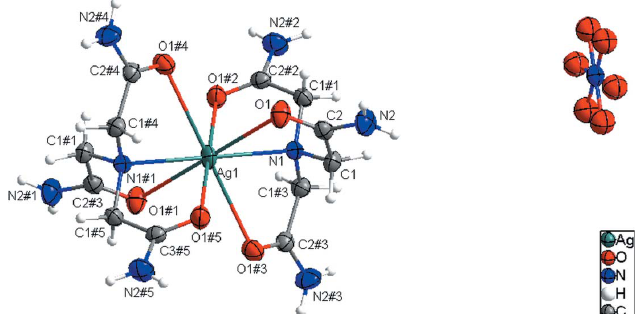
Table 2 Experimental details.